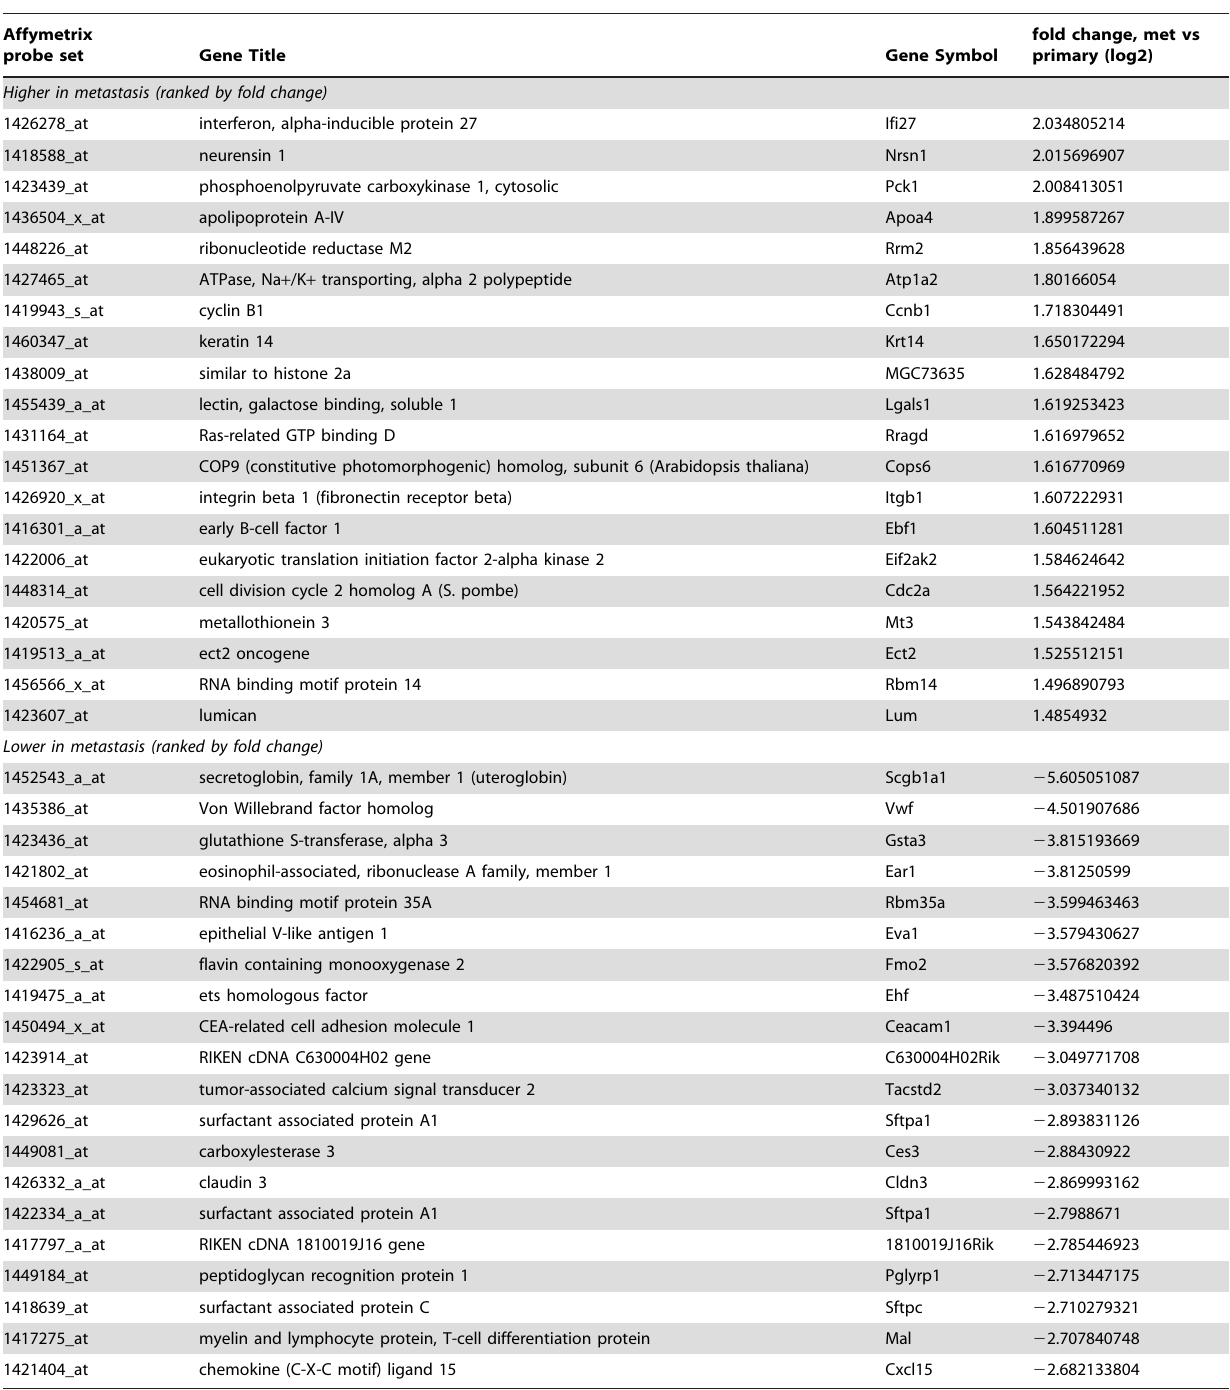
Table 2. Top named genes differentially expressed ( P , 0.01) between primary tumors and metastasis.